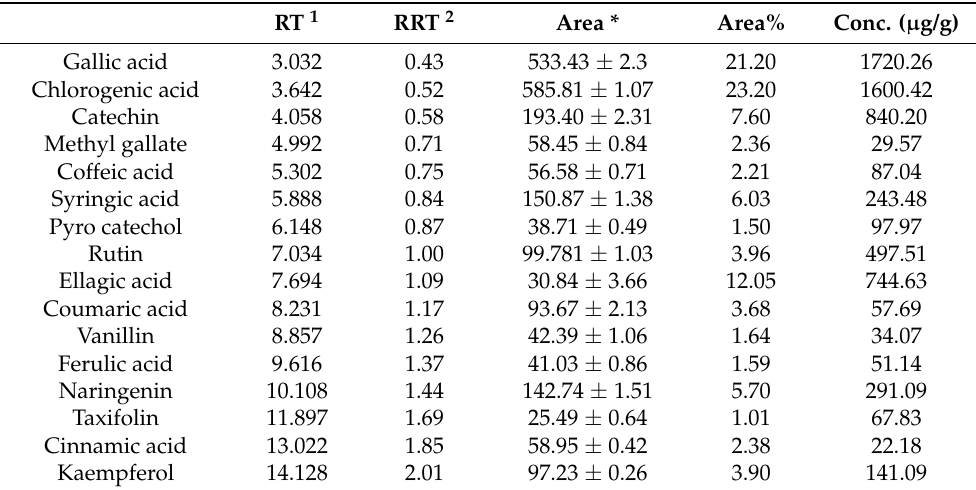
Table 1. Phenolic compounds of P. auriculata Lam. aerial parts identified by HPLC.